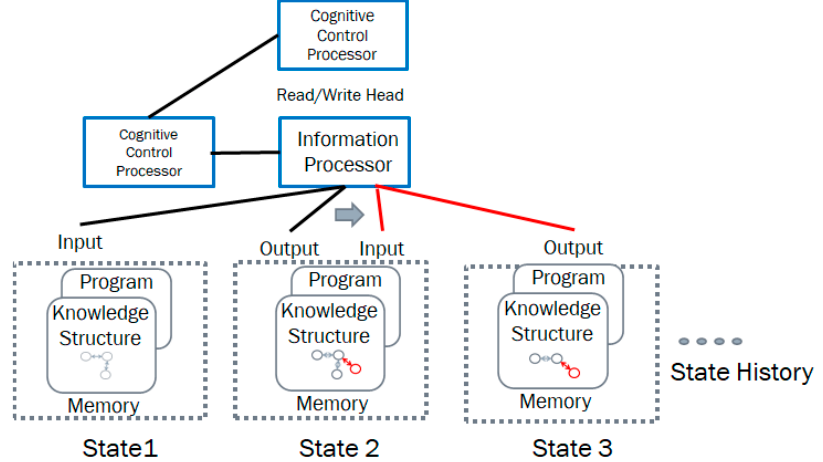
Figure 3. A structural machine operating on knowledge structure